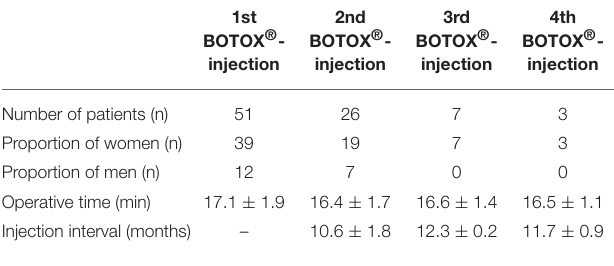
TABLE 2 | Perioperative parameters of the patient population.